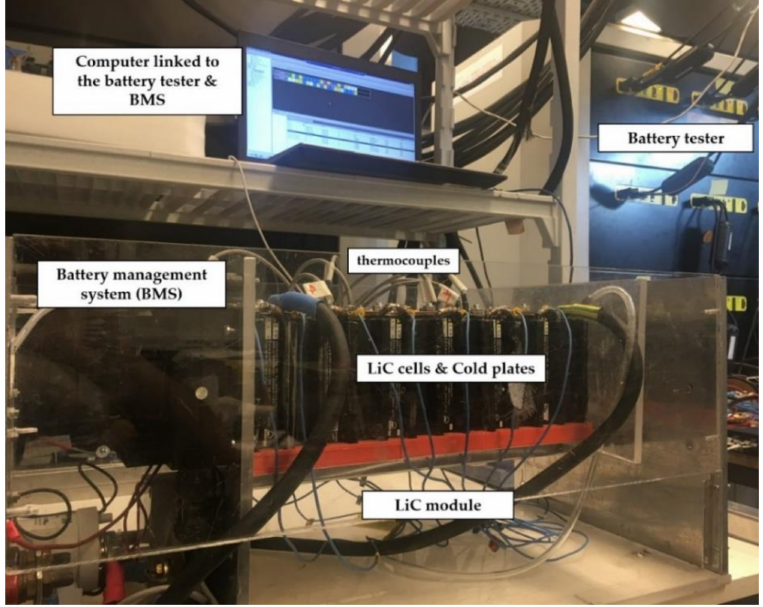
Figure 6. The forced LCTMS experimental test bench for the LiC